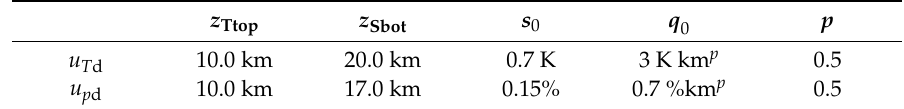
Table 1. Parameter settings for the observational uncertainty model for dry temperature and dry